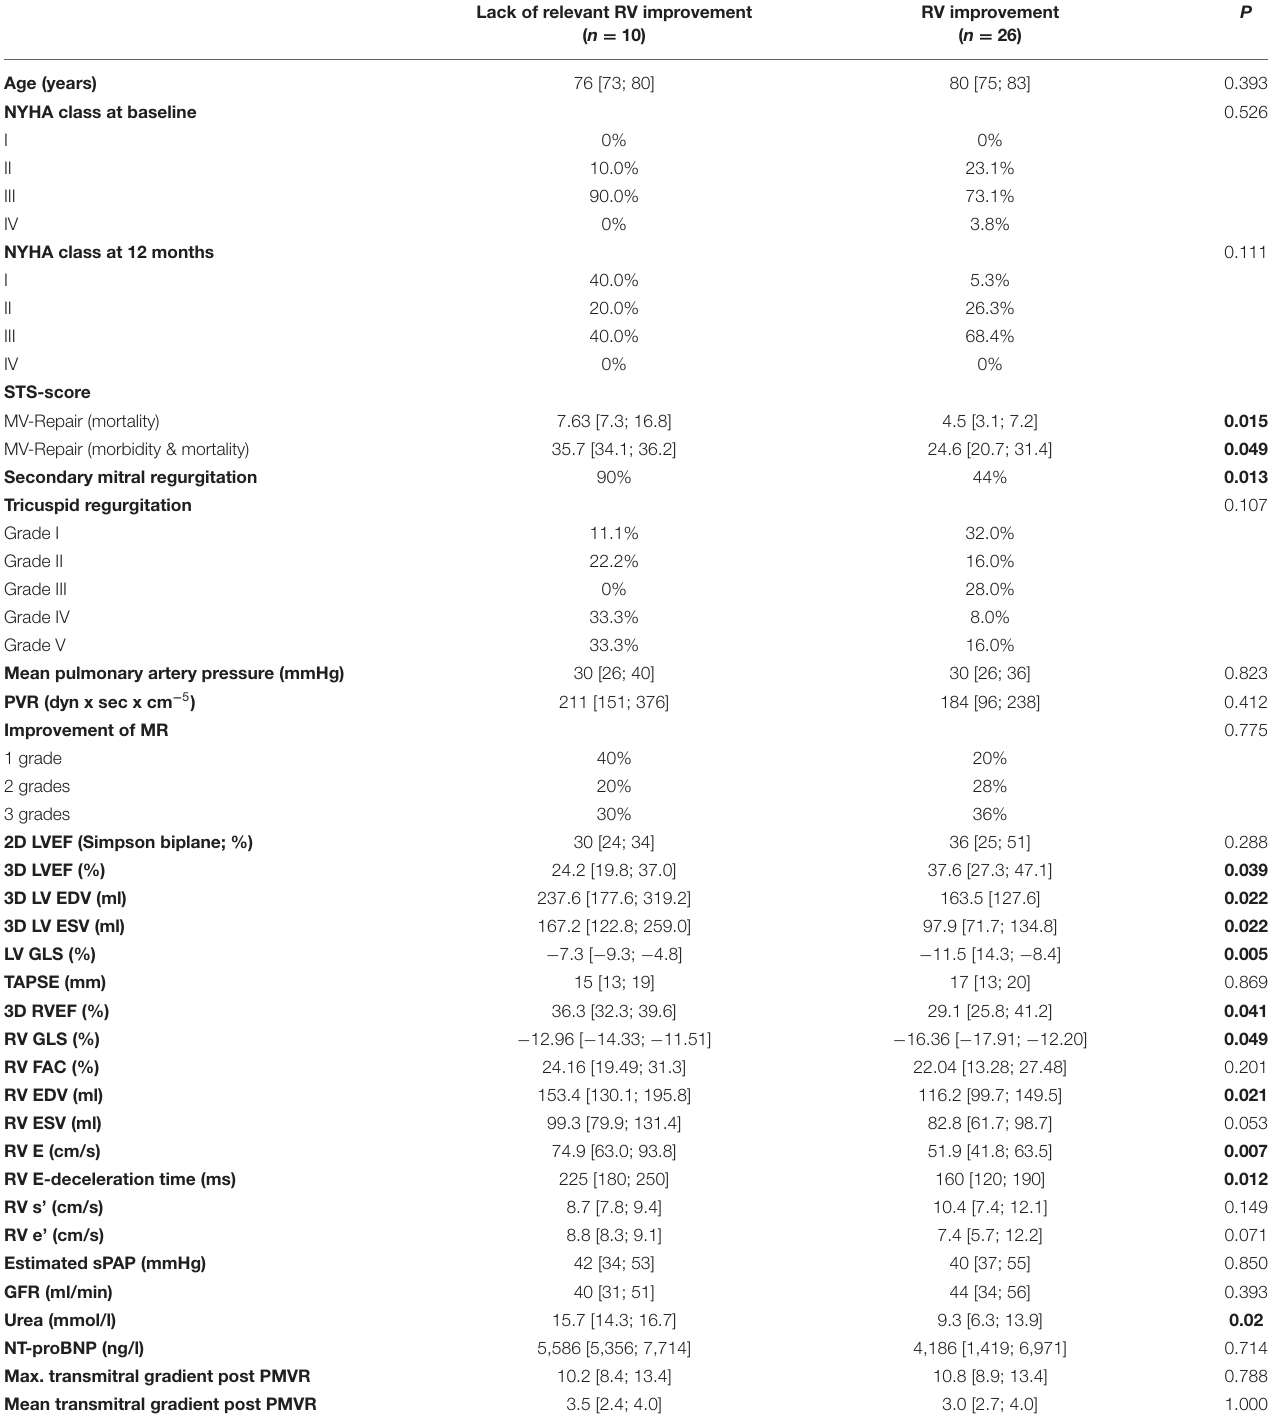
TABLE 3 | Improvement vs. Non-improvement of RV function after percutaneous mitral valve repair (PMVR) in the subgroup of patients with reduced RV function (RVEF ≤ 45%) at baseline ( n =